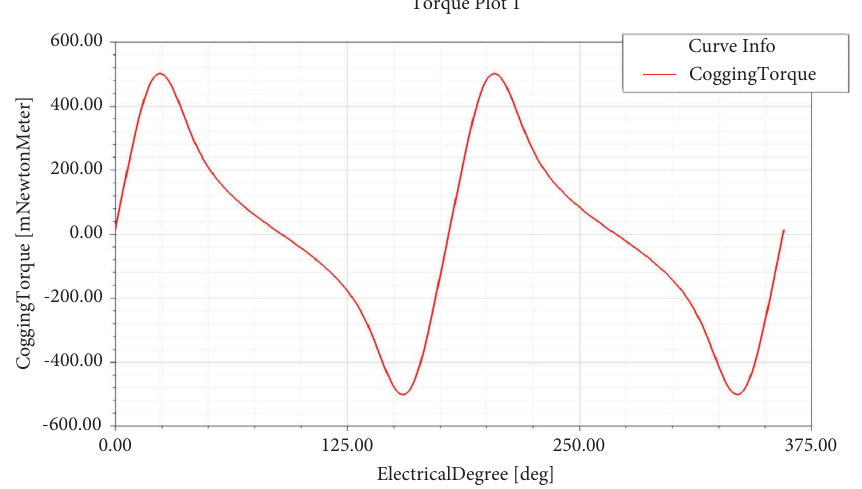
Figure 24: Cogging torque of pear-shaped slot